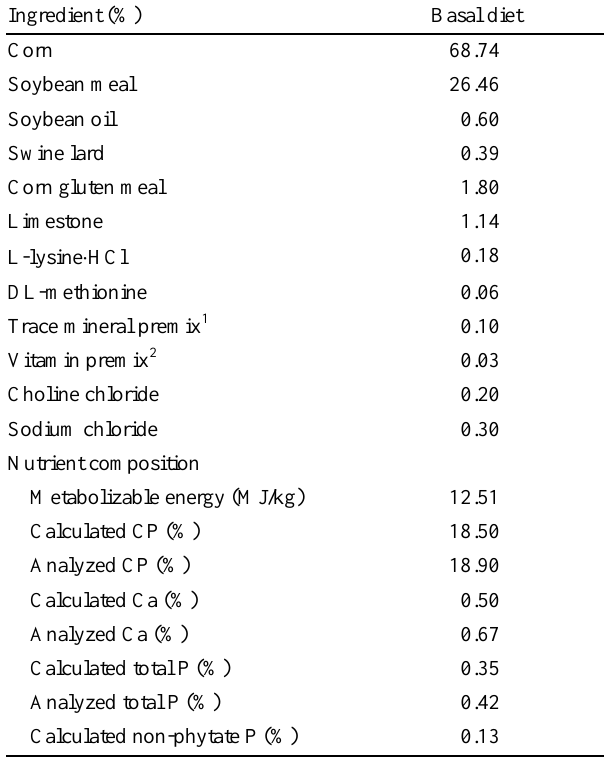
Table 1. Ingredients and nutrient composition of the basal